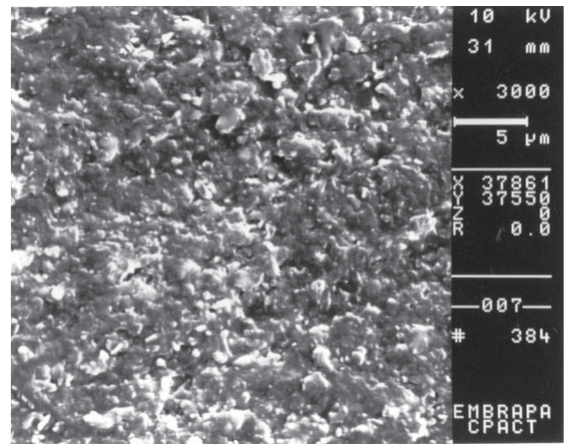
Figure 4. SEM micrography of Artglass surface after 90 days of aging (SEM original magnification 10000 × ).